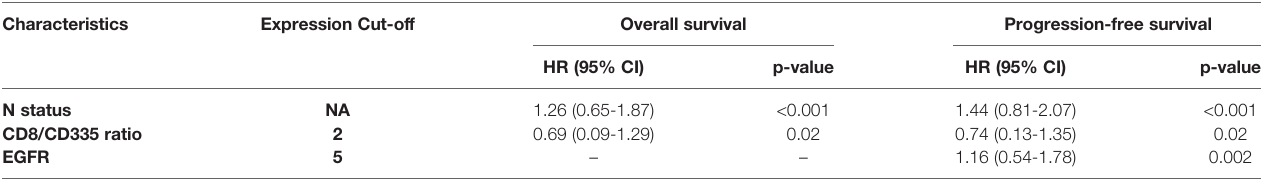
TABLE 2 | Multivariate analysis of overall and progression-free survival.